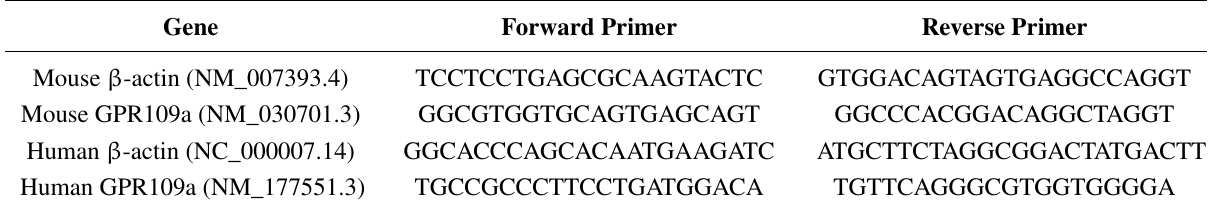
Table 1. Sequences of specific primers used for real-time quantitative RT-PCR. Gene Forward